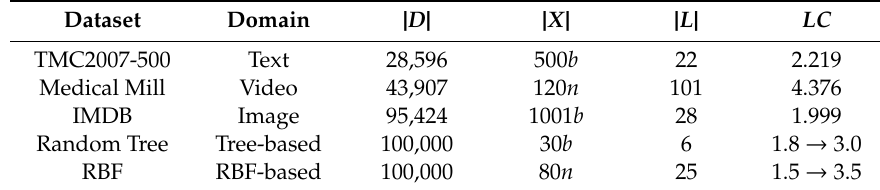
Table 1. The characteristics of